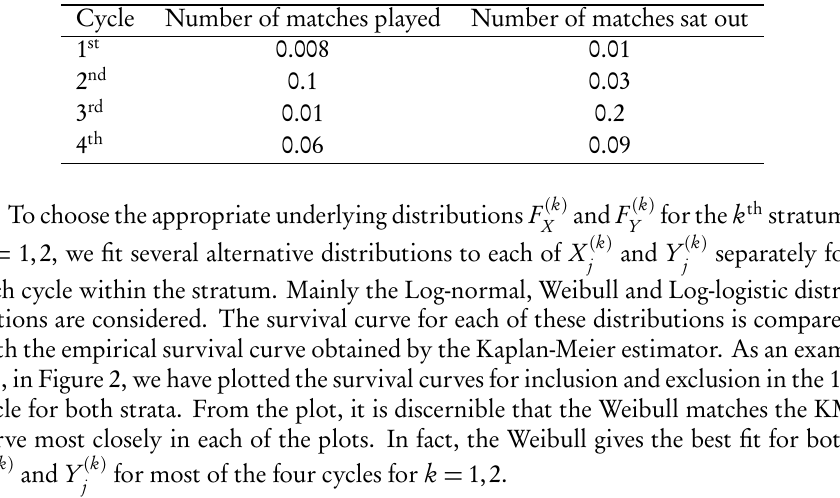
Results showing the p-values for testing the similarities in survival curves among batsmen and